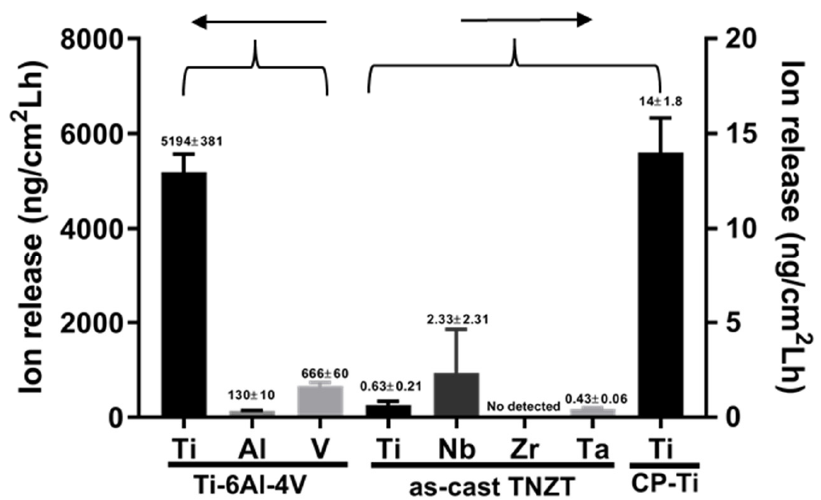
Figure 7. Concentrations of the ions released for CP-Ti and Ti-6Al-4V compared to as-cast TNZT after 735 h of immersion.